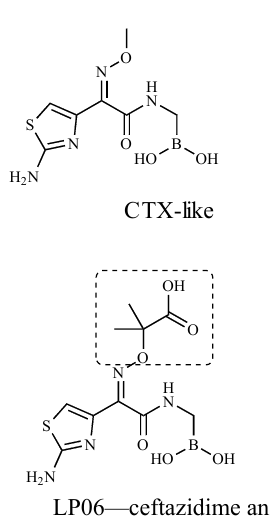
Figure 1. Compounds used in this study. R1 and R2 indicate side chains that are analogous to those of β -lactam substrates. Dashed lines indicate the portion of LP06 that is missing in the electron density of the FOX-4 / LP06 crystal structure (PDB: 5CHM). * An extra carbon linker is present on the R2 side